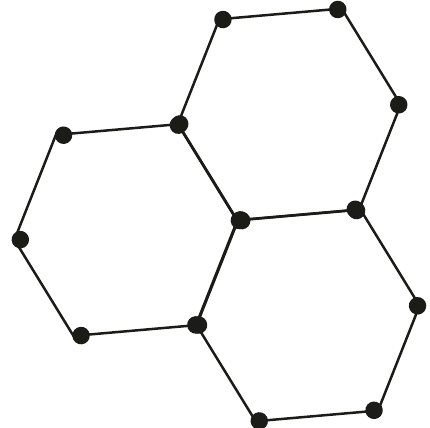
Figure 1: Schematic diagram of carbon atoms’ structure in a graphene